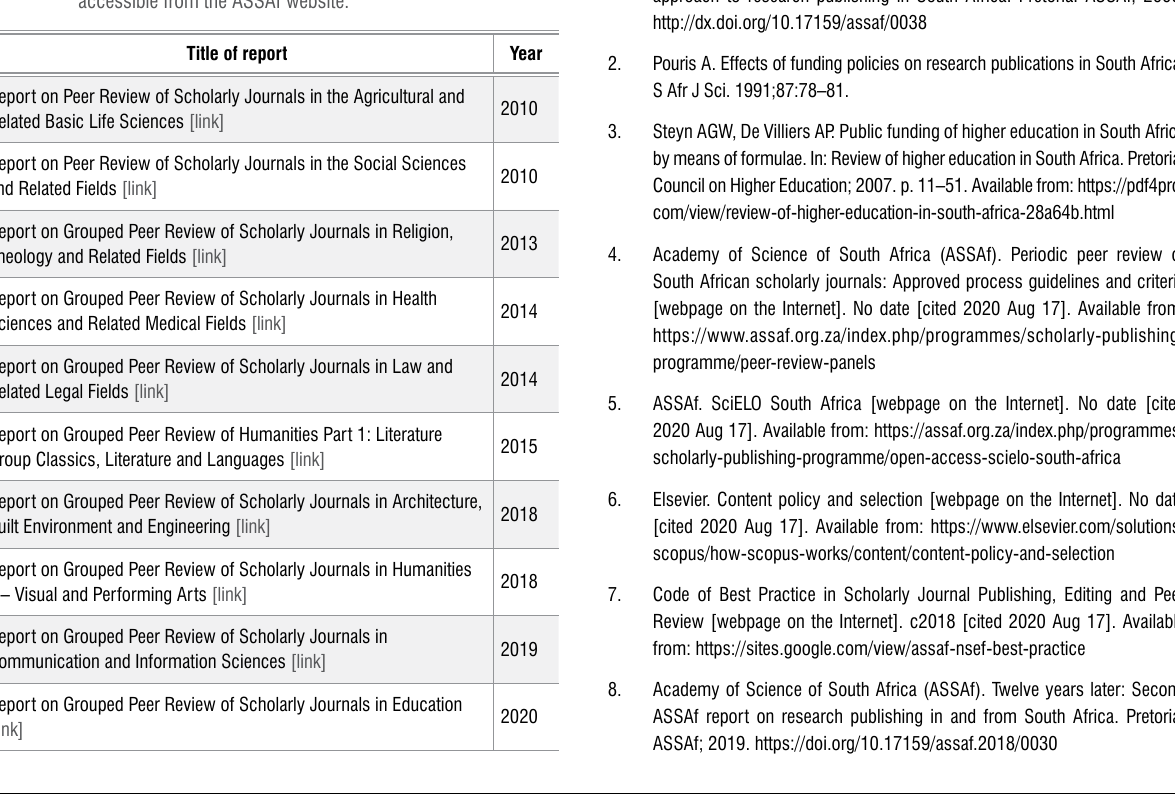
The group peer review reports on scholarly journals in particular disciplines that have been carried out to date. The year of publication of the reports is listed. All are openly accessible from the ASSAf